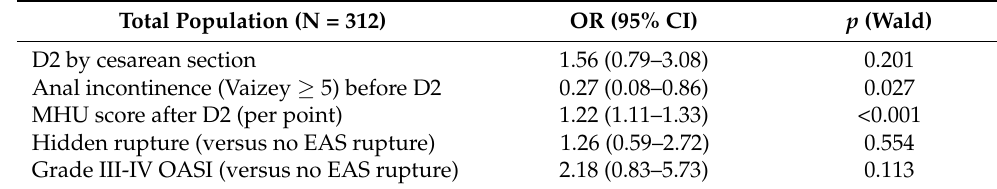
Table 5. Factors associated with a worsening of the Vaizey score ≥ 2 points after second delivery (Multivariate